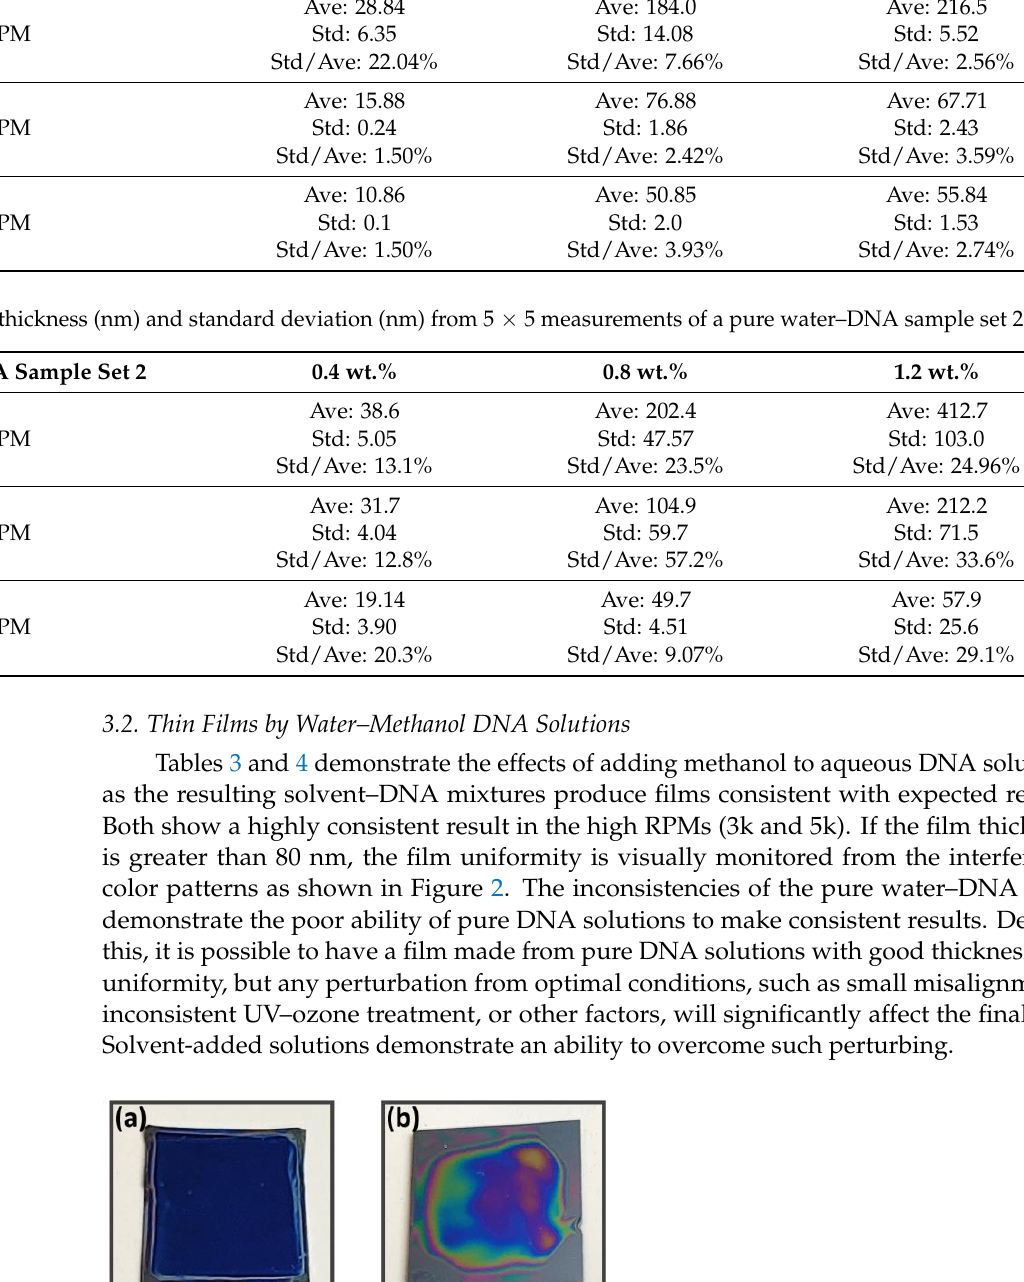
Table 1. Average thickness (nm) and standard deviation (nm) from 5 × 5 measurements of a pure water–DNA sample set 1. Pure Water–DNA Sample Set 1